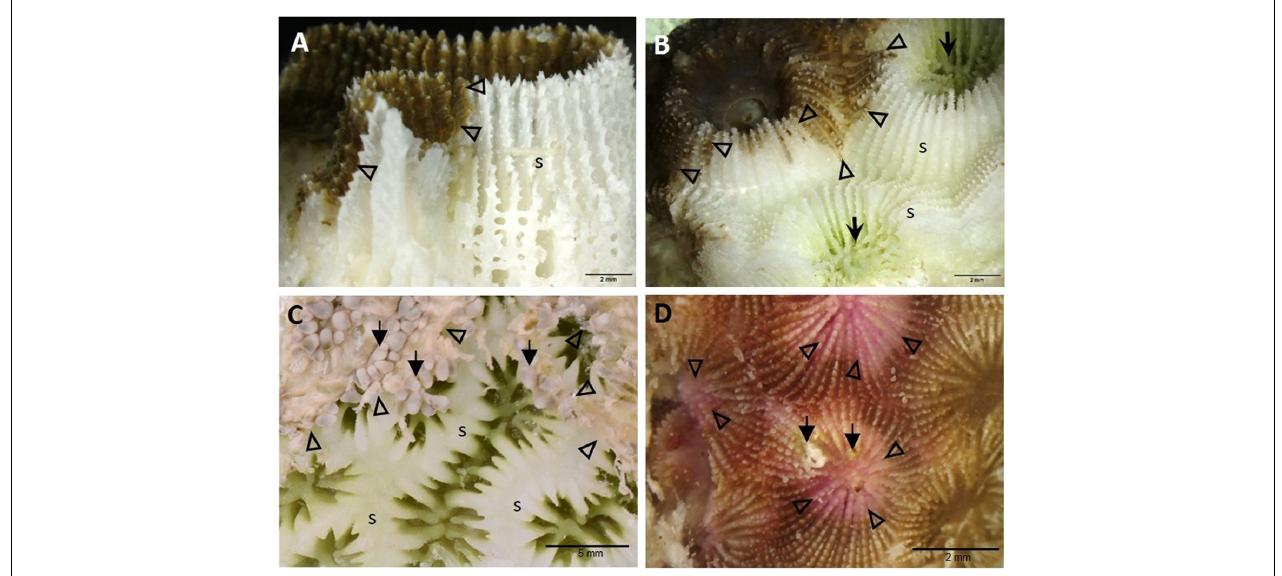
FIGURE 4 | High-magnification gross macrophotographs of fixed core samples showing different anatomical examples of demarcation borders between tissue-loss margins and apparently healthy surface areas in various species. (A) Pseudodiploria strigosa showing exposed white skeleton adjacent to active disease margin (arrowheads) along the septum. (B) Montastraea cavernosa showing the multifocal progression of tissue loss (arrowheads) along the septa of two adjacent polyps. Note green algal coloration (arrows) in chronically exposed bare skeleton around the oral regions. (C) Dendrogyra cylindrus showing the progression of the tissue-loss margins (arrowheads) around the polyps, with some tentacles still partly intact (arrows), exposing the skeletal ridges. (D) Siderastrea siderea with pinkish discoloration of tissue loss areas around the polyp oral cavities and septa, showing tissue-loss margins (arrowheads) and overgrowth of algae (arrows). (A) Near Shore Patch, April 2018; (B,D) Broward County, November 2016; (C) Long Key Ledge, April 2018. s =